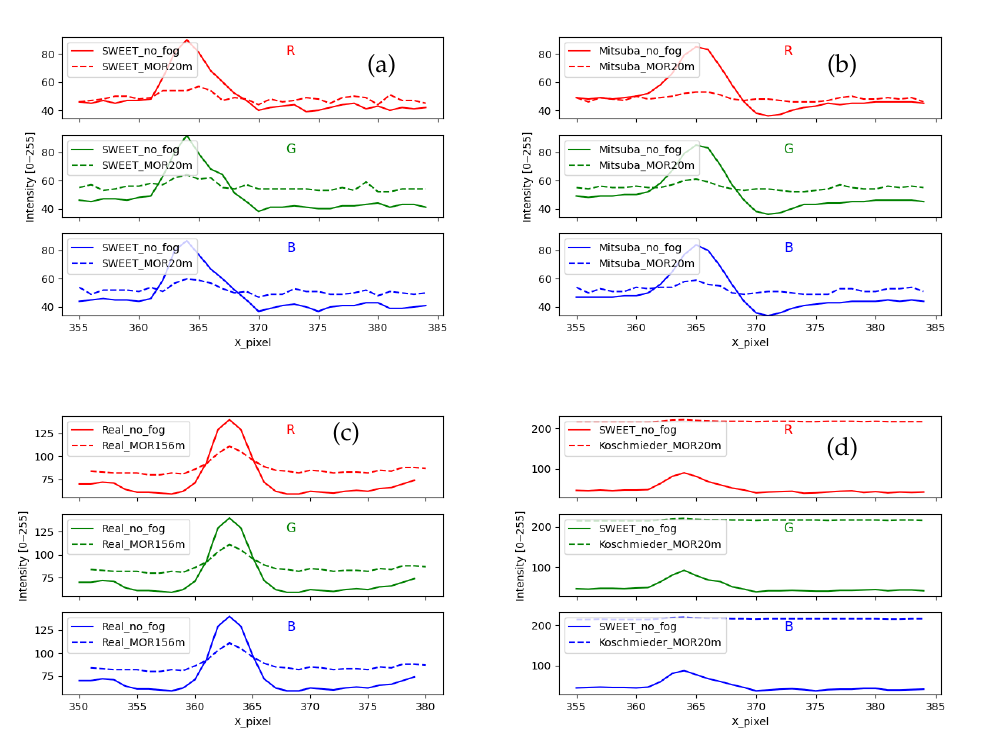
Figure 12. Comparing the intensity of a pixel line for images coming from SWEET ( a ), Mitsuba ( b ), real camera images ( c ) and Koschmieder ( d